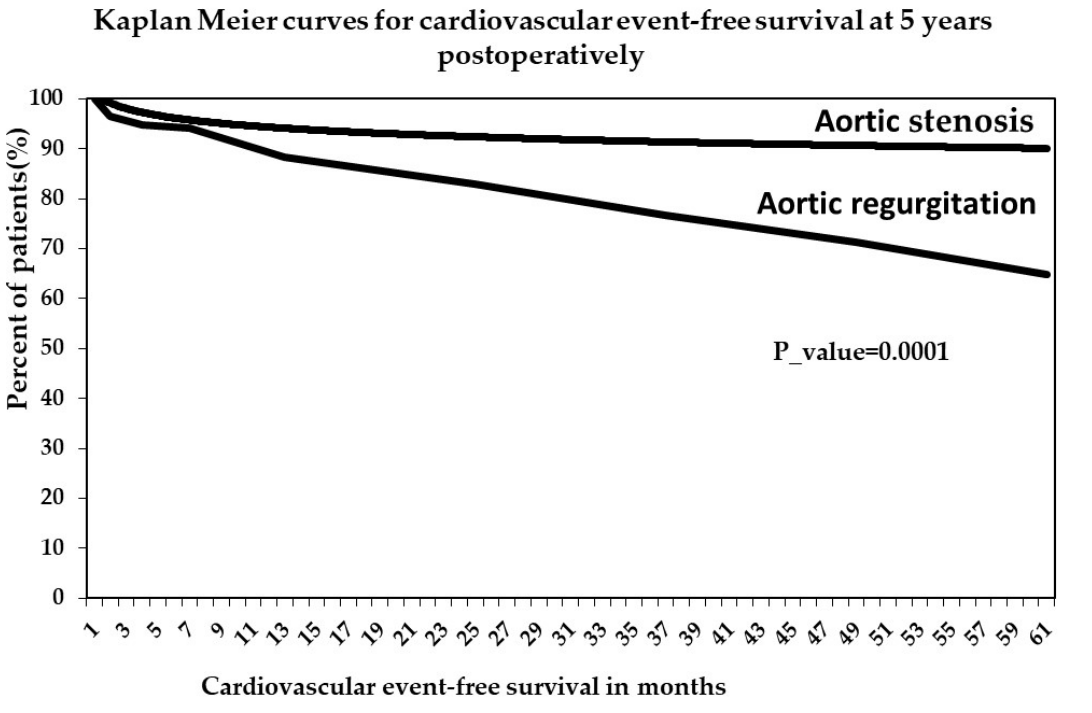
Figure 1. Kaplan–Meier curves for cardiovascular event-free survival at 5 years postoperatively. The main independent predictors for death and hospitalization for HF at 5 years postoperatively in patients with aortic valve disease undergoing AVR revealed by univariate logistic regression analysis and the associated RR (95% CI) were: restrictive LVDFP (RR = 6.8 (5.9, 7.6), p = 0.001), preoperative AR (RR = 3.12 (2.57, 3.74), p = 0.0001), severe preoperative LV systolic dysfunction with an LVEF less than 35% (RR = 2.7, p =0.035), severe preoperative PHT with mean PAP > 50 mmHg (RR = 2. 36 (2.37, 3.29), p = 0.021), patients’ age of more than 75 years (RR = 1.86 (1.74, 2.07), p = 0.032), comorbidities (RR = 1.95 (1.67, 2.79), p = 0.071), moderate LV systolic dysfunction with LVEF between 35 and 50% (RR = 2.03 (1.51, 2.73), p = 0.053), and dilated LV with preoperative LVES diameter > 55 mm (RR = 2.27 (1.65, 2.95), p = 0.059). Moreover, univariate regression analysis showed that the preoperative AR in patients with restrictive LVDFP turned out to be an independent predictor for increasing the mortal- ity rate ( p = 0.0001), with preoperative AR being more harmful for postoperative evolution in AVR patients. At 1 year postoperatively, the main independent prognostic predictors for the pa- tients with aortic valve disease undergoing AVR revealed by multivariate logistic re- gression analysis were (Figure 2): restrictive LVDFP (RR = 9.8, p = 0.001), severe LV systolic dysfunction with a LVEF less than 35% (RR = 8.7, p = 0.002), severe PHT (PHT) with mean PAP > 50 mmHg (RR = 8.2, p = 0.021), patients’ age of more than 75 years (RR = 8.1, p = 0.013), the presence of preoperative AR (RR = 6.9, p = 0.031), comorbidities (RR = 1.9, p = 0.071), moderate LV systolic dysfunction with LVEF between 35 and 50% (RR = 1.7, p = 0.074), and dilated LV with LVES diameter > 55 mm (RR = 1.8, p = 0.067). For regression analysis, in order to identify the prognostic predictors, we used baseline echocardiographic